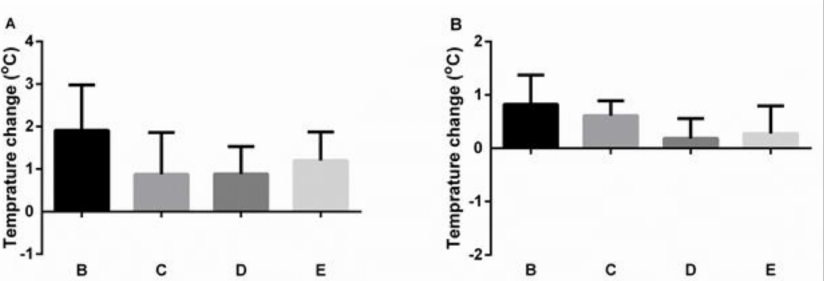
Figure 4. Core body temperature after OIT gavage. During the fourth and fifth rounds of OIT, before and 20 min after oral gavage of nOVAmax and OVA, the core body temperature was measured, and the temperature change is depicted. Graph ( A ) shows the values measured during the fourth round, graph ( B )—the values measured during the fifth round.